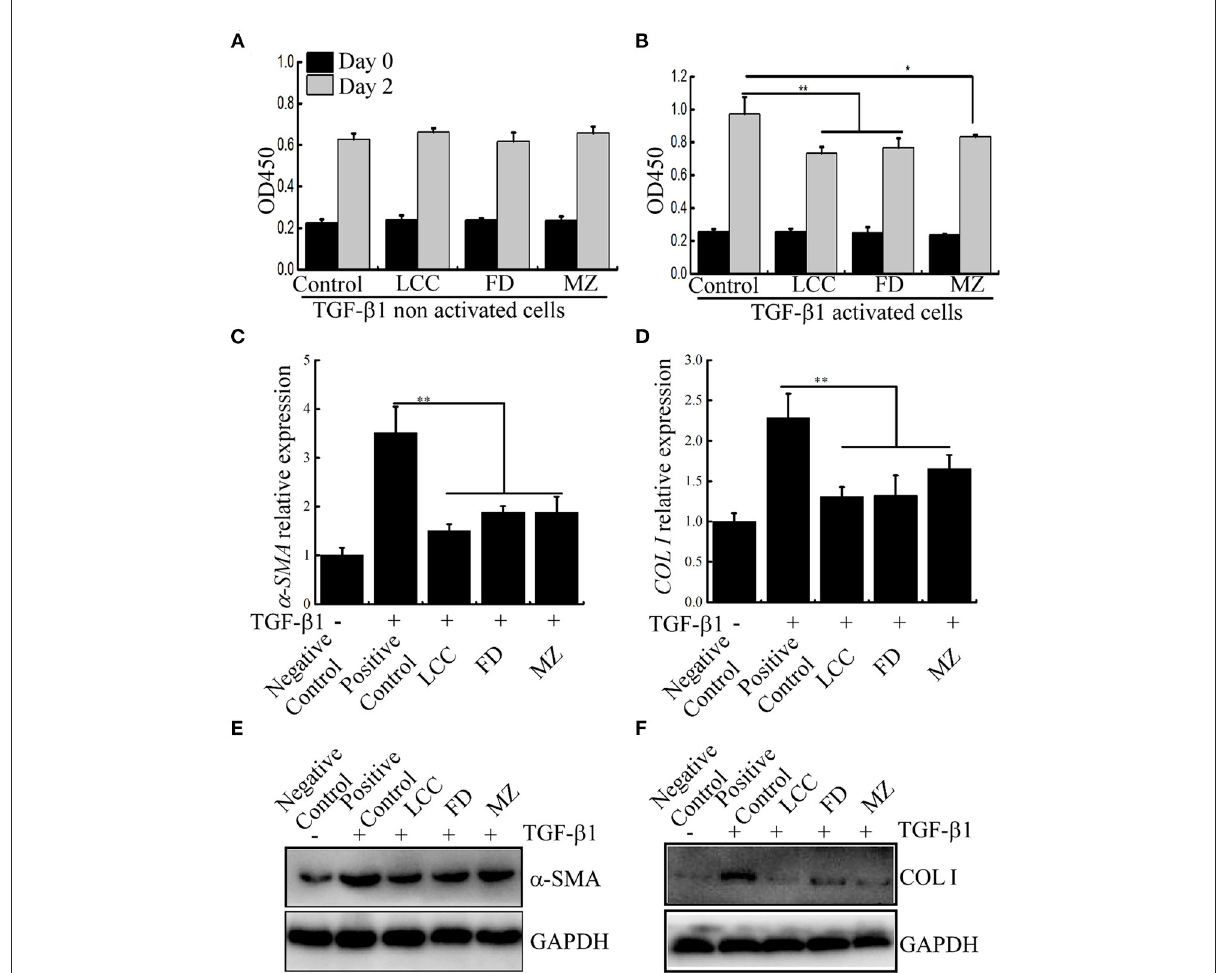
FIGURE3 The effects of TEVs on the proliferation of LX-2 cells. (A) The effect of TEVs on TGF- β 1 non activated LX-2 cells proliferation. (B) The effect of TEVs on TGF- β 1 activated LX-2 cells proliferation. (C) mRNA expression of α -SMA was analyzed by Real-time PCR. (D) mRNA expression of COL I was analyzed by Real-time PCR. (E) Protein expression of α -SMA was determined by western blotting. (F) Protein expression of COL I was determined by western blotting. Error bar represents SD ( n = 3; * P < 0.05, ** P < 0.01, indicating significantly different from control